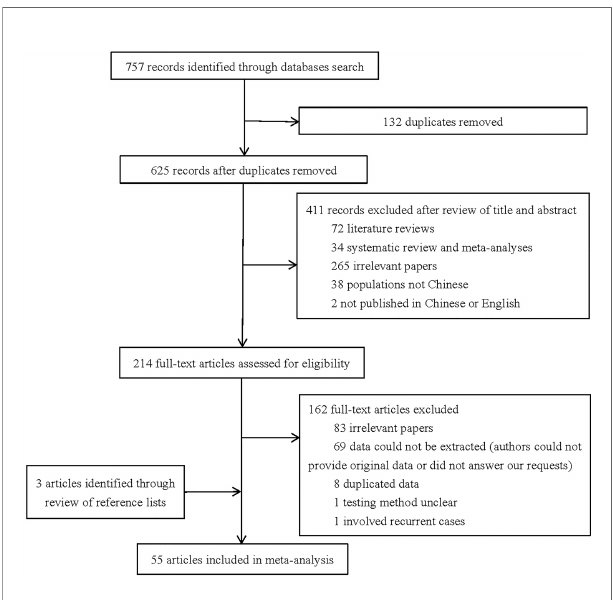
FIGURE 1 | Flow diagram of studies